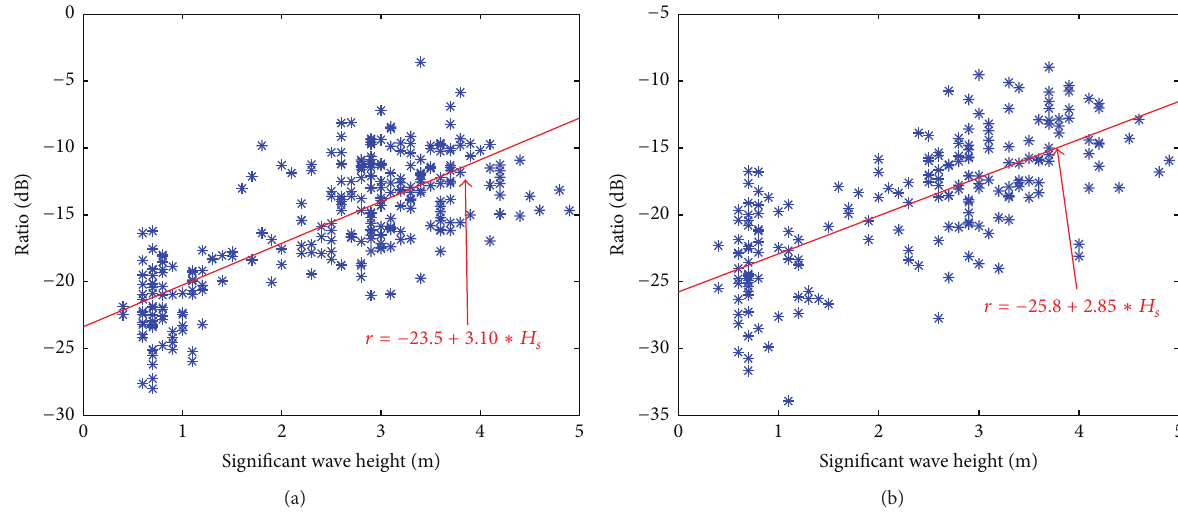
Figure 3: Ratios of the SHPs to the Bragg peaks fitted to the wave buoy data: (a) from 70 degrees; (b) from 120 degrees.